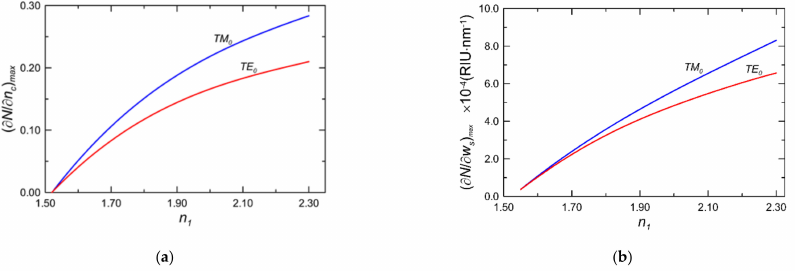
Figure 7. Influence of refractive index of the waveguide film on maximum value of the homoge- neous sensitivity ( a ) and surface sensitivity ( b ). Wavelength and parameters describing the planar waveguide are given in the caption of Figure